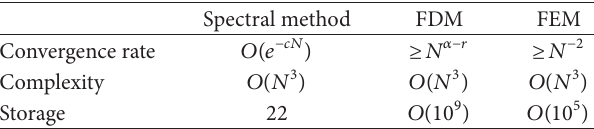
Table 1: Comparison with FDM and